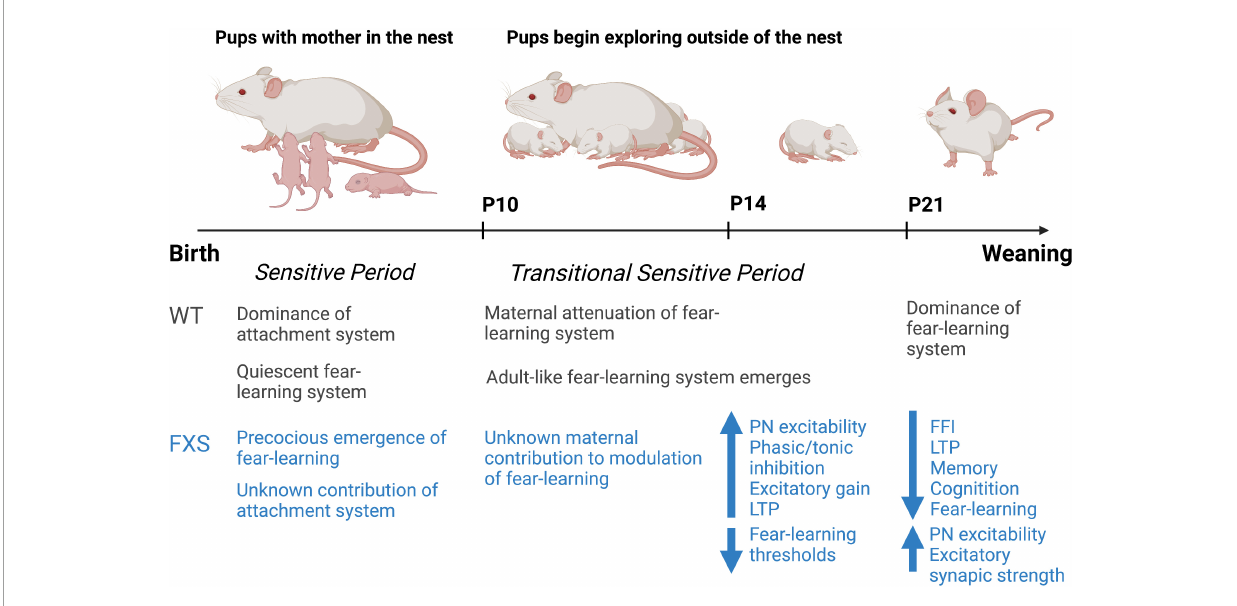
FIGURE1 Summary timeline of observed changes in early development in the Fmr1 KO mouse compared to the wild-type rodent. Figure adapted from previous work by Regina